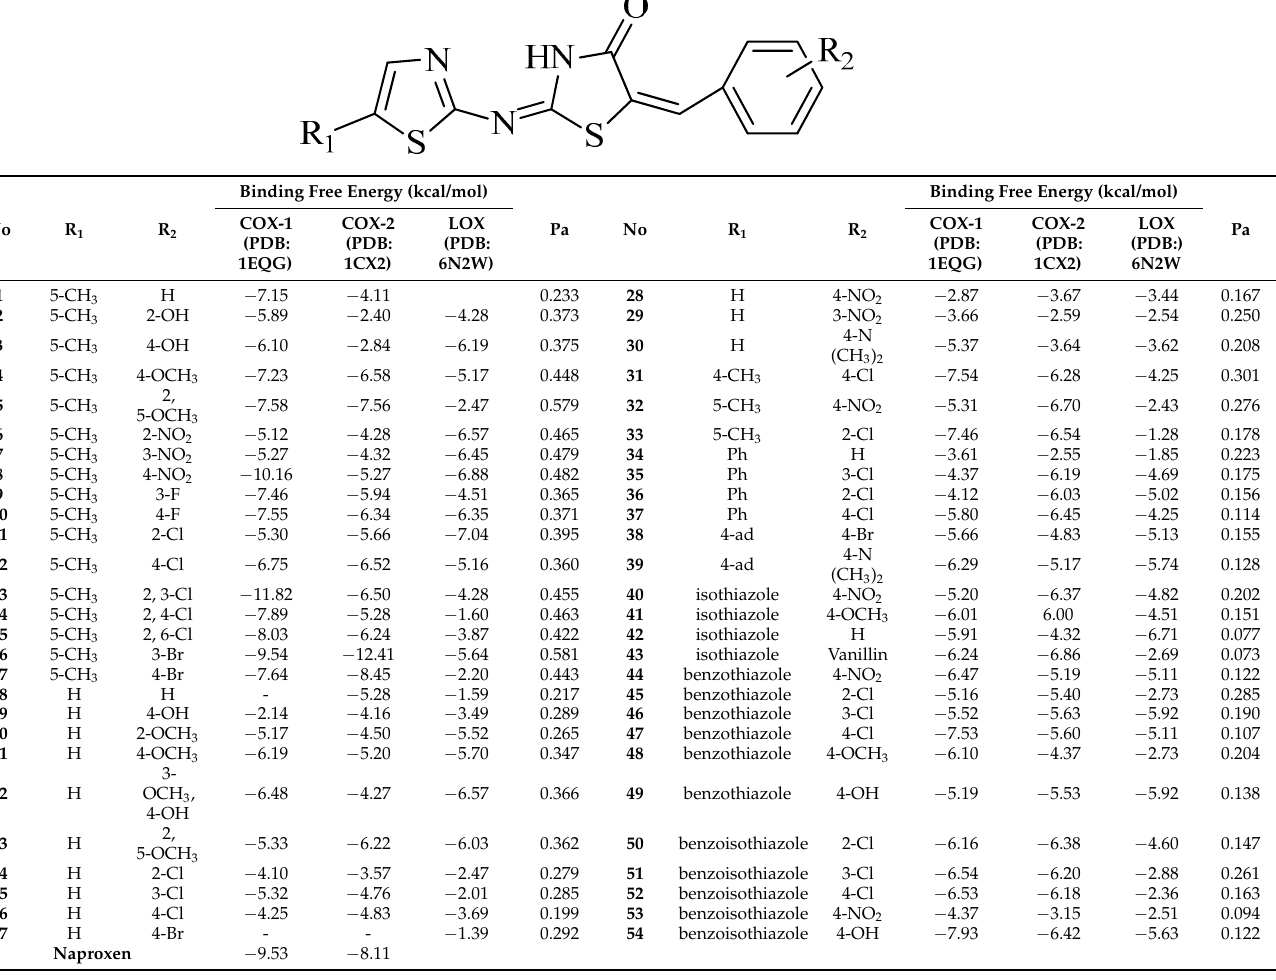
Table 1. Anti-inflammatory PASS prediction and Docking assisted predicted values against COX-1, COX-2 and LOX.